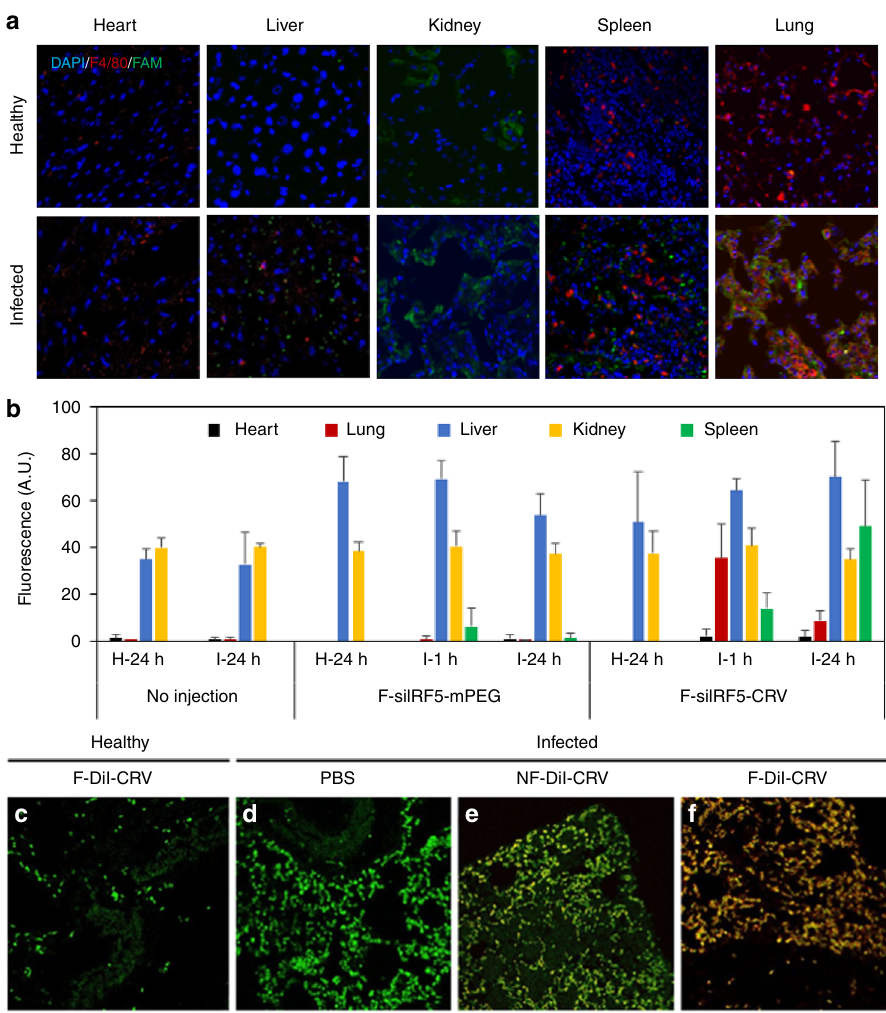
Fig. 4 Targeting peptide and fusogenic uptake enhances homing to infected lungs and macrophages. a Immuno fl uorescent sections of major organs of healthy and infected Balb/C mice injected with FAM-CRV.peptide (green). Blue indicates cell nuclei stained with DAPI, red indicates macrophages marked by F4/80 antibody stain. b Quanti fi ed fl uorescence signals (IVIS 200) from organs of healthy and infected Balb/C mice injected with fusogenic nanoparticles containing DiI membrane stain and si Irf5 payload, with either a non-targeting (F-siIRF5-mPEG) or the CRV targeting group (F-siIRF5-CRV) at doses of 23.2 µ mol/kg lipid, 24 µ g/kg siRNA, 0.5 mg/kg pSi. “ H-24 ” indicates healthy Balb/C organs "collected 24 h post treatment; “ I-1 ” indicates Balb/C organs of infected harvested 1 h post; treatment; and “ I-24 ” indicates infected Balb/C organs 24h post-" treatment. Error bars indicate SD. Data are representative of n = 3, quanti fi ed by ImageJ analyses. c – f Confocal microscope images of DiI-loaded fusogenic and non-fusogenic nanoparticles homed to infected lung with pendant CRV targeting peptide. These nanoparticles contained no si Irf5 payload; green indicates macrophages (FITC-tagged rat anti- mouse F4/80 stain), red indicates lipophilic DiI from nanoparticles; c lung of healthy mouse injected with F-DiI-CRV; d lung of infected mouse injected